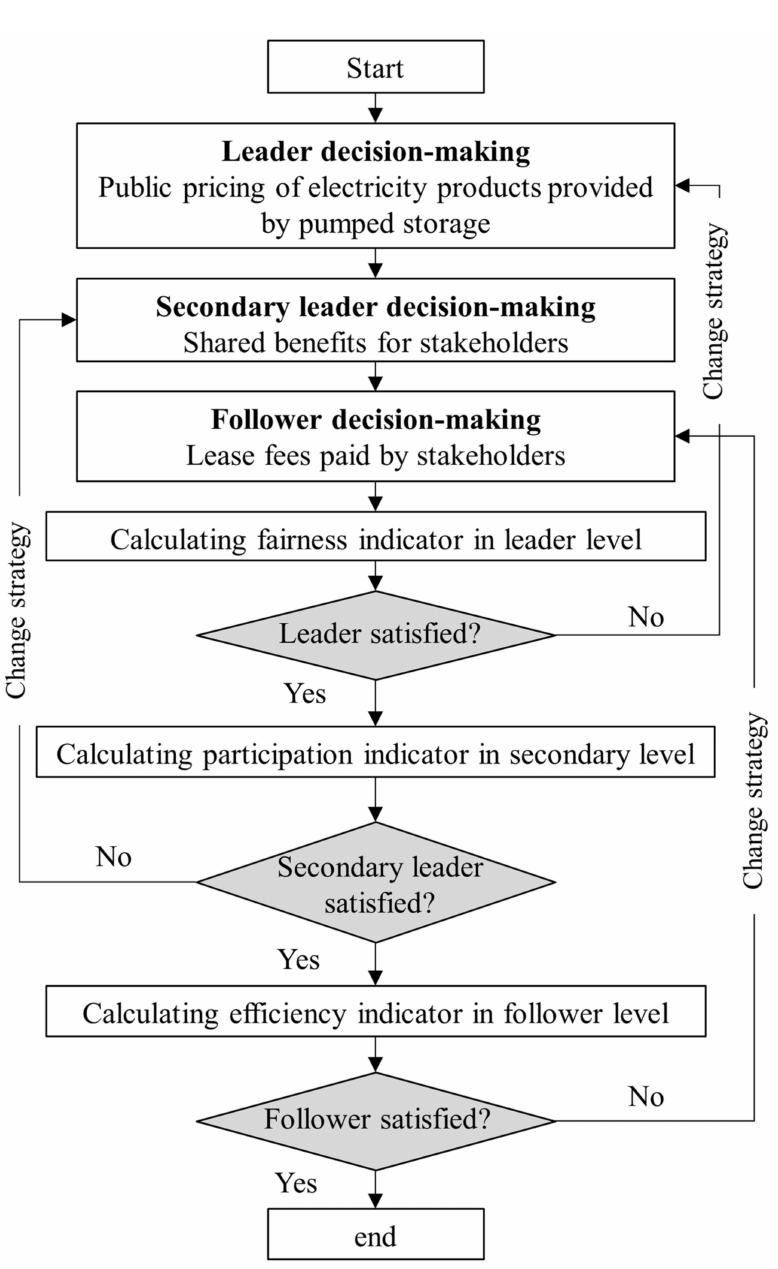
Figure 2. The flow chart of the decision-making mechanism and model-solving